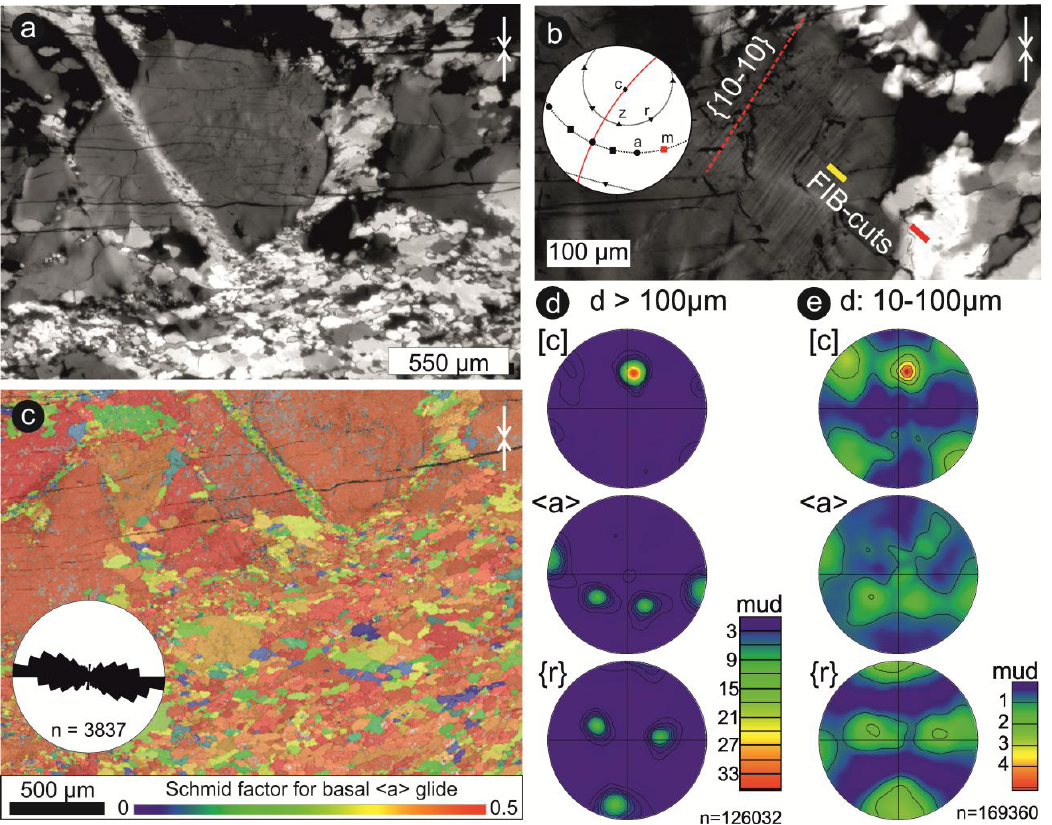
Fig. 8. Microfabric of quartz after “kick and creep” experiment CR1-13, initially deformed at 400 ◦ C, 2GPa confining pressure, and strain rate of 10 − 4 s − 1 , and afterwards at 900 ◦ C, 2.5GPa confining pressure and approximately constant stress. The shortening direction is indicated by white arrows. (a) Polarized light micrograph showing partly recrystallized quartz. (b) Polarized light micrograph showing SWUE in large original quartz grain. Yellow and red lines mark locations of FIB cuts for TEM foils, from which bright field micrographs are shown in Fig. 9c and d, respectively. The crystallographic orientation of the main grain is shown by the pole figure. (c) EBSD map showing Schmid factor for basal h a i glide by colour code. (d, e) Pole figures (density plots) showing crystallographic orientation of grains with diameter larger than 100µm and of grains with diameters of